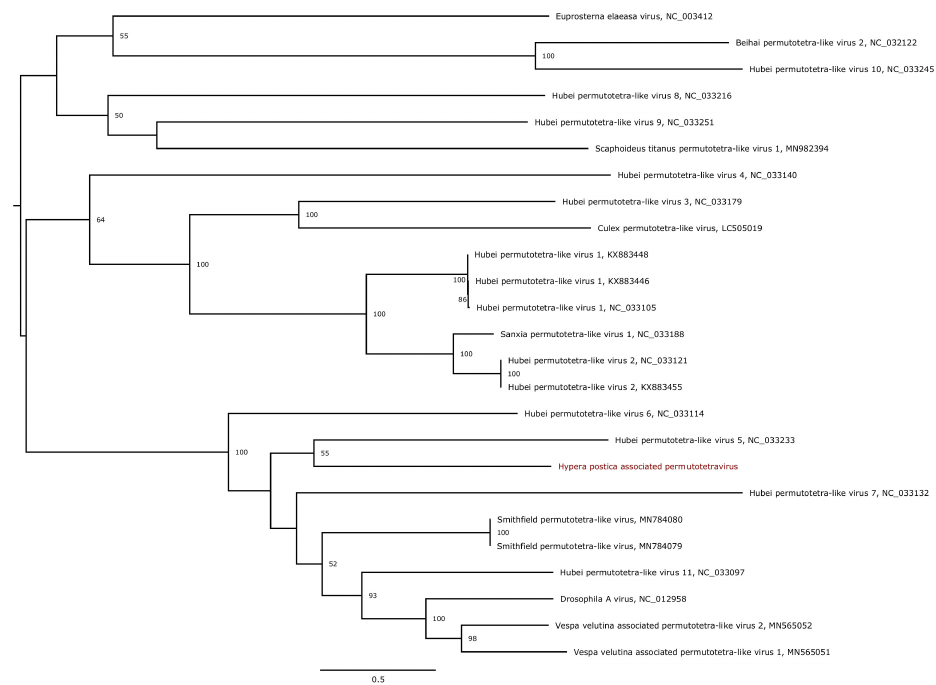
Figure 8. Maximum likelihood phylogenetic tree based on the RNA-dependent RNA polymerase protein of 25 permu- totetraviruses. The virus reported in this study is marked in red. The tree was mid-point rooted. Bootstrap values (1000 replicates) superior to 50% are indicated at each node. Scale bar corresponds to amino acid substitutions per